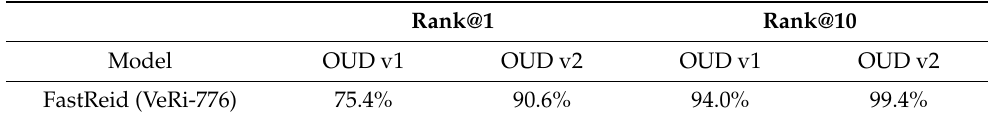
Table 6. Rank@1 and rank@10 metrics for vehicle re-identification in OUD datasets. Rank@1 Rank@10